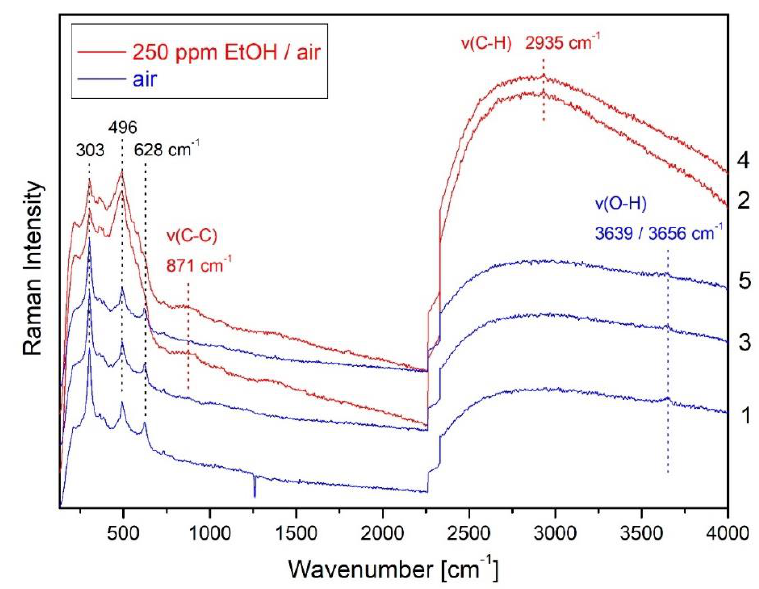
Figure 11. Operando surface-enhanced Raman spectroscopy (SERS) during EtOH sensing at 190 °C using In 2 O 3 doped with Ag. Raman spectra were recorded at 514.5 nm excitation when switching between air (blue) and EtOH/air (red). Spectra are offset for clarity. Modified from [35].